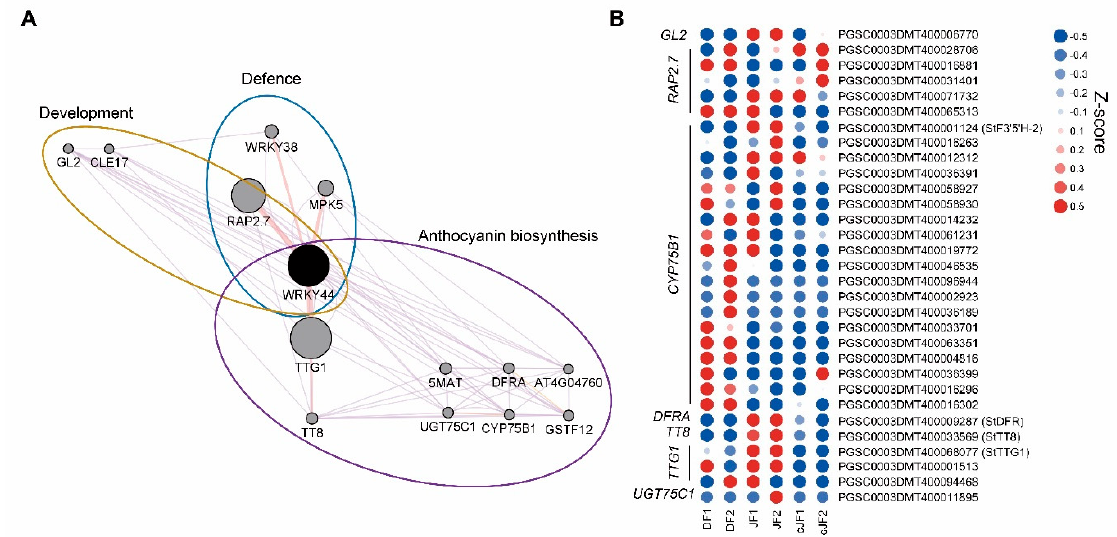
Figure 6. Network analysis of WRKY44 and expression patterns of WRKY44 network genes. ( A ) Network analysis of WRKY44. Pale purple lines indicate co-expression network and pale red lines indicate physical interaction. ( B ) Heatmap of WRKY44 network genes. Z-scores for each gene were used. Numbers in sample names indicate biological replicate number.